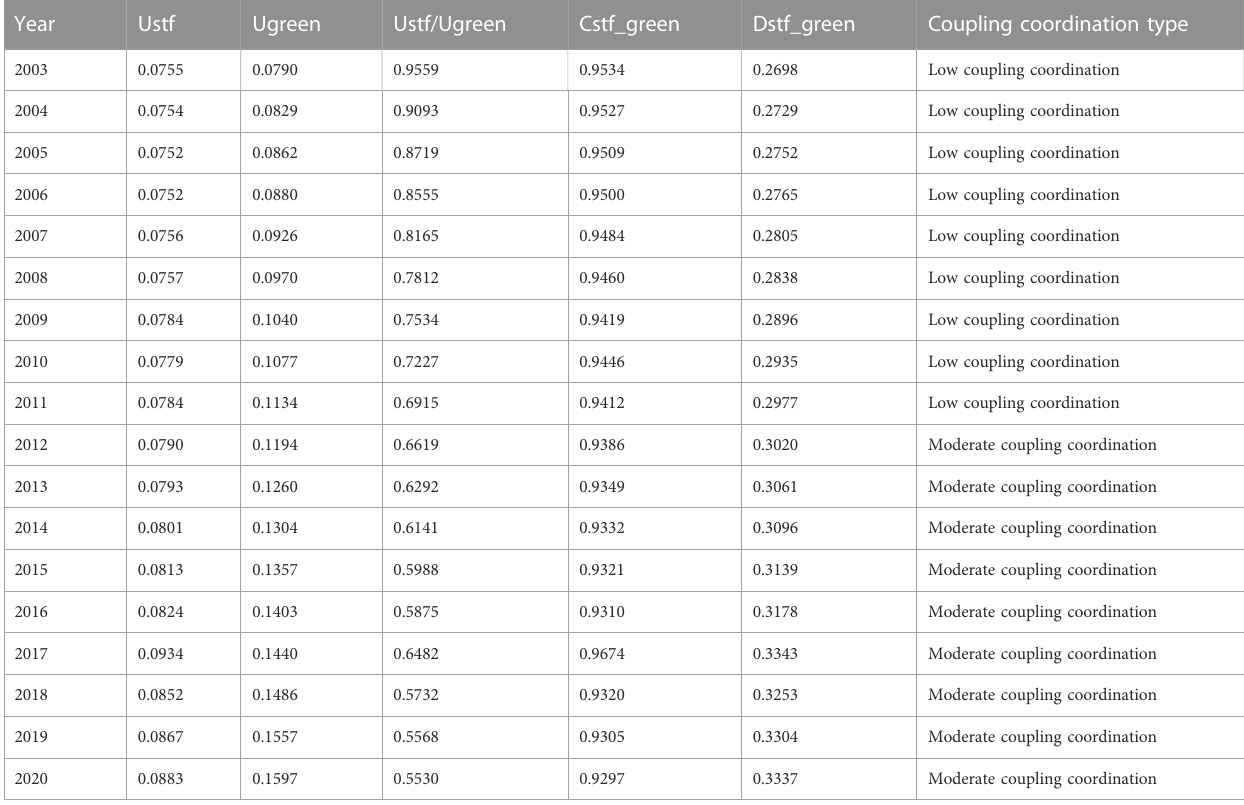
TABLE 5 The overall characteristics of the coupling and coordination relationship between science and technology fi nance and green